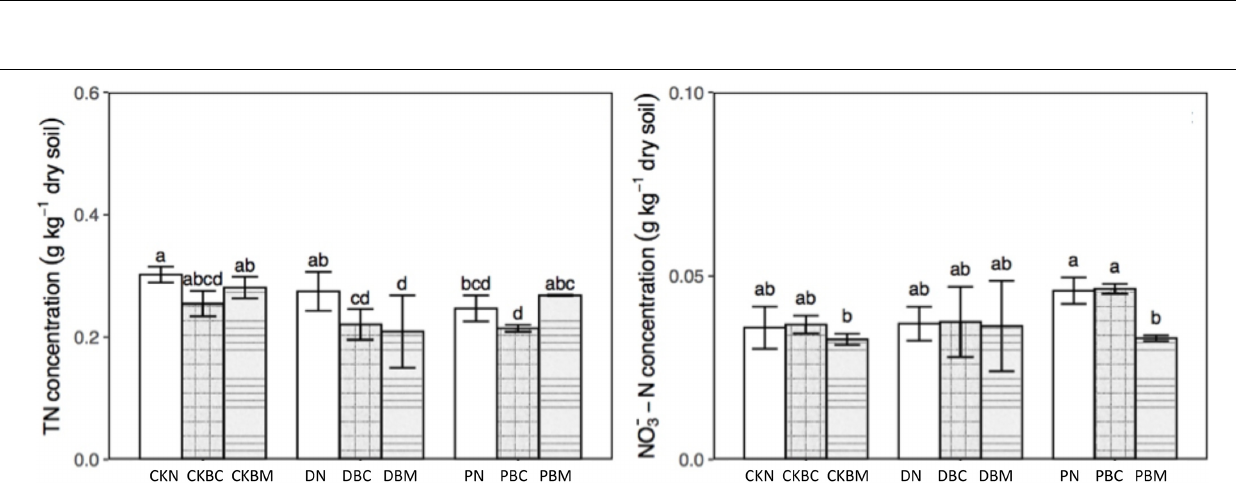
FIGURE 1 | DOC, DIC, and TC concentration of different treatments. Different letters mean significant differences, and the same letters mean no significant difference, Duncan ( p < 0.05). DOC, dissolved organic carbon; DIC, dissolved inorganic carbon; TC, total dissolved carbon.